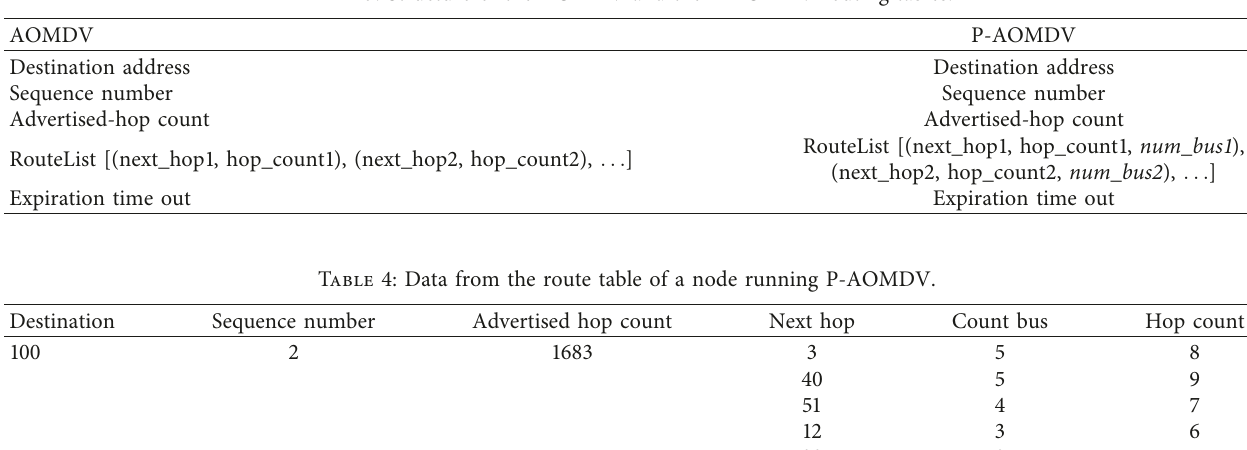
Table 3: Structure of the AOMDV and the P-AOMDV routing tables.